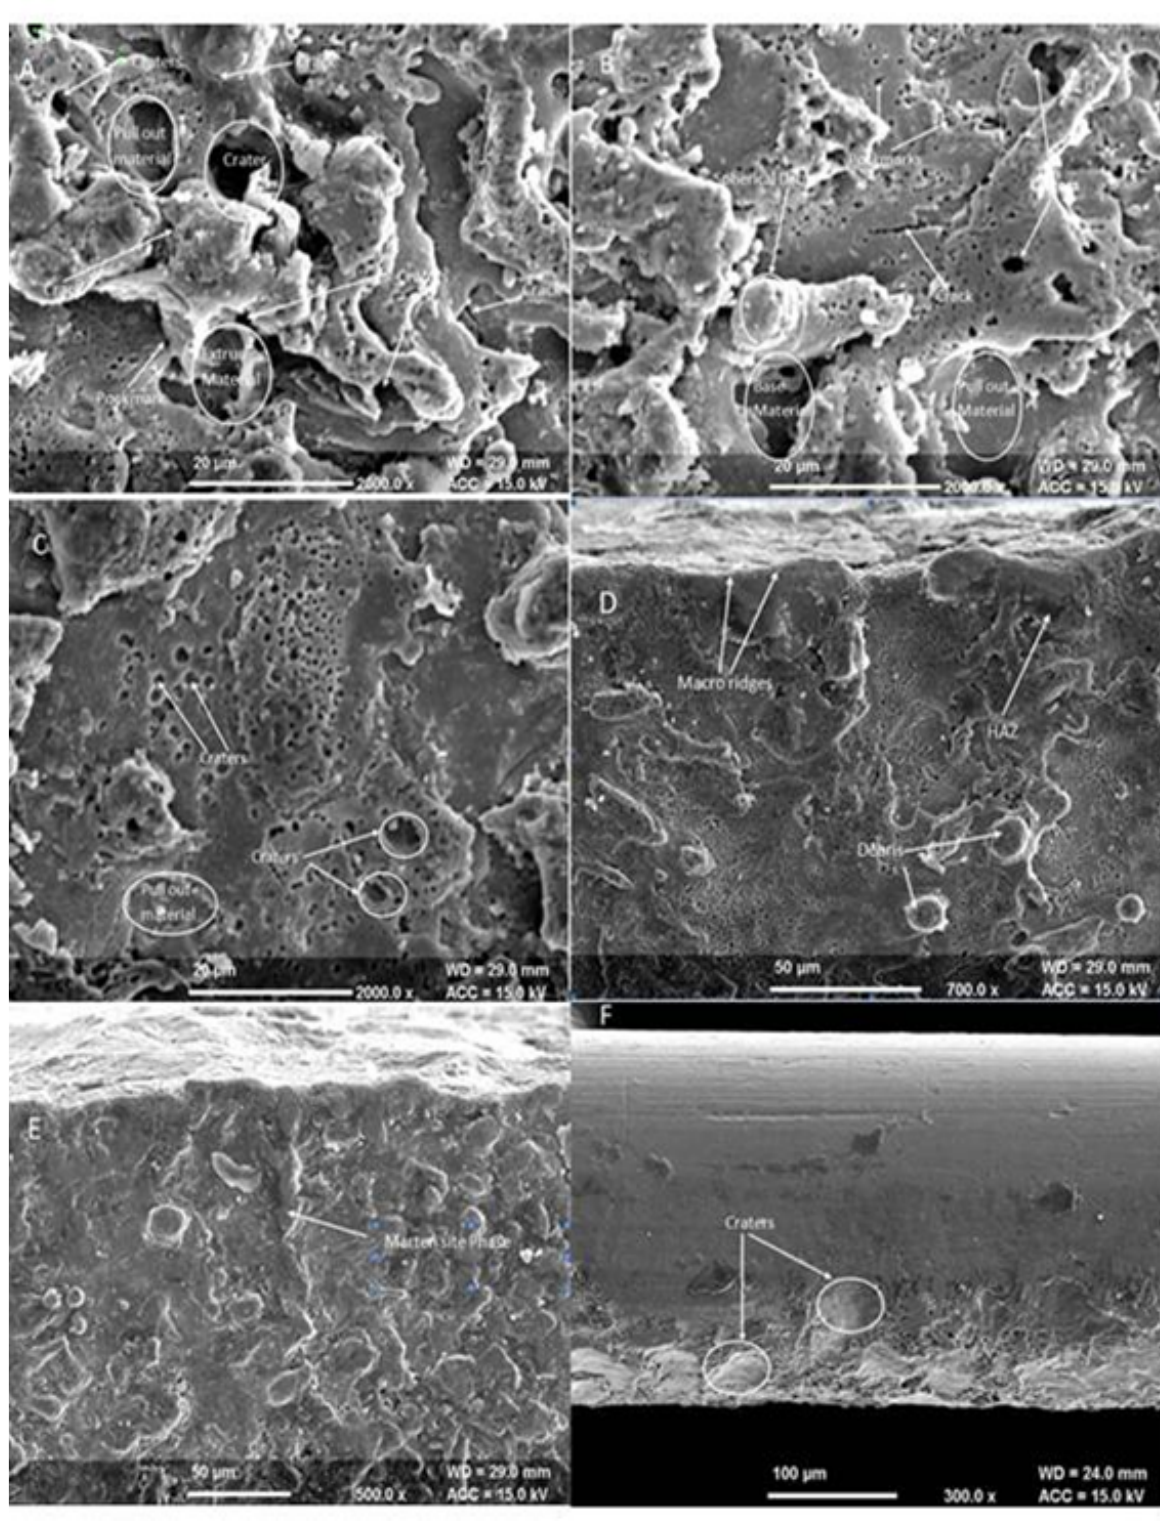
Figure 11: Scanning electron micrographs of work material under optimized